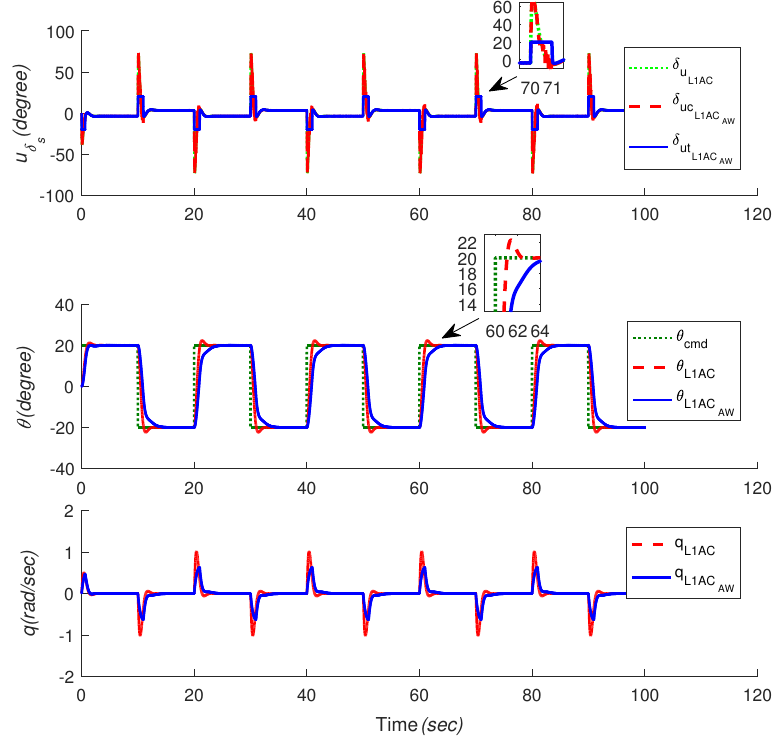
Figure 5. Pitch channel control in the presence of the actuator saturation for linear plant tracking θ cmd (pulse